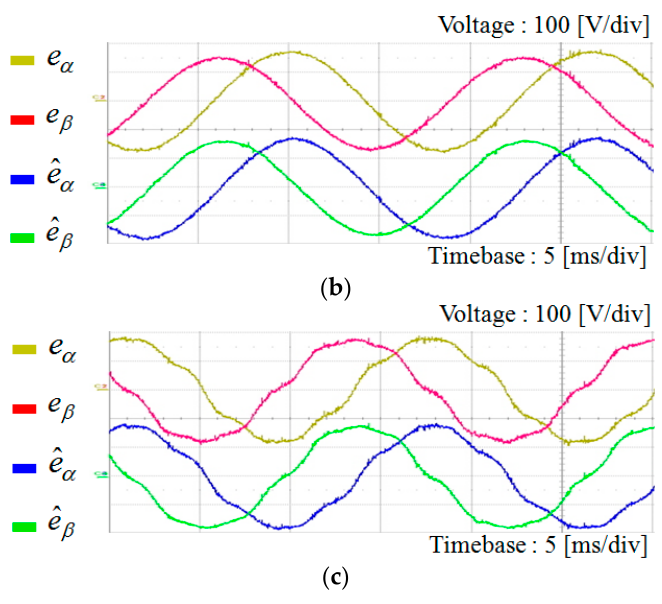
Figure 15. Experimental results for the estimation of grid voltages using DOB. ( a ) Under the ideal grid voltages; ( b ) under unbalanced grid voltages; and ( c ) under harmonic distorted grid voltages.